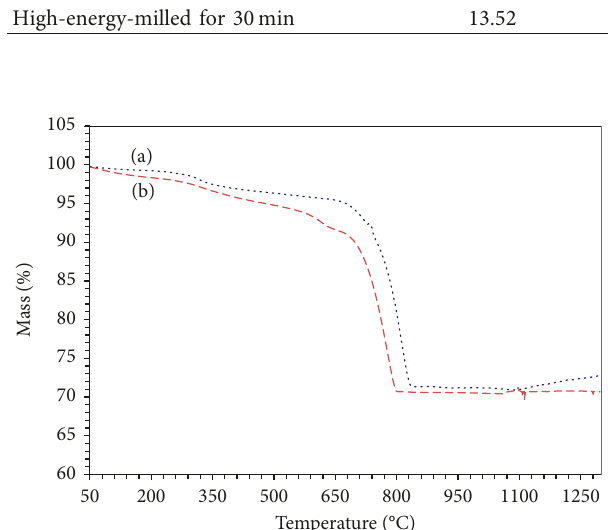
Figure 6: TG curves of duck eggshell +A-TiO 30min and (b) high-energy-milled for 30min.